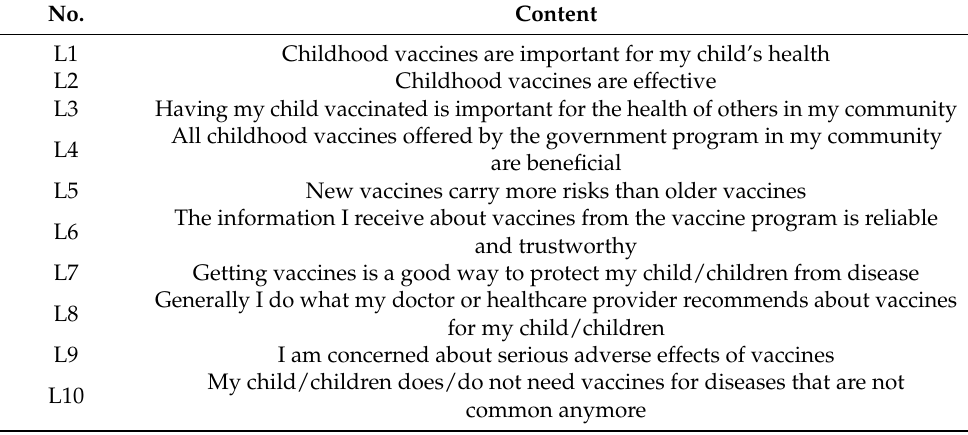
Table 1. The 10-item Likert